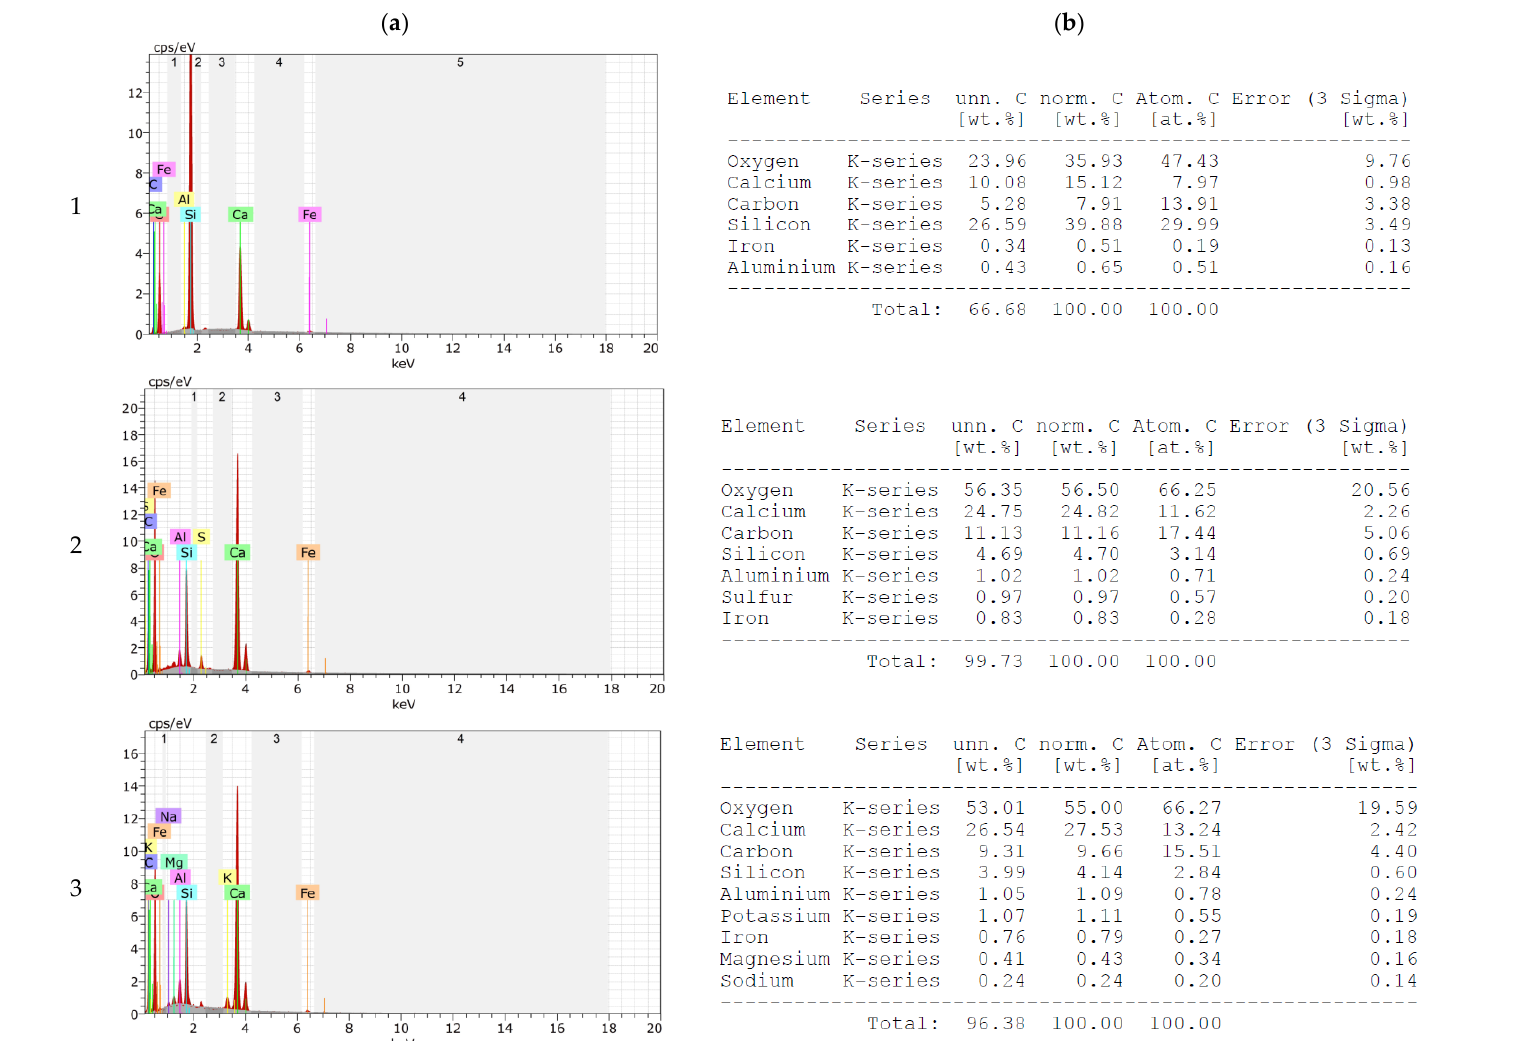
Figure 8. Results of EDS procedure of samples made of cement CEM I 42.5 R ( a ) with their element composition ( b ).